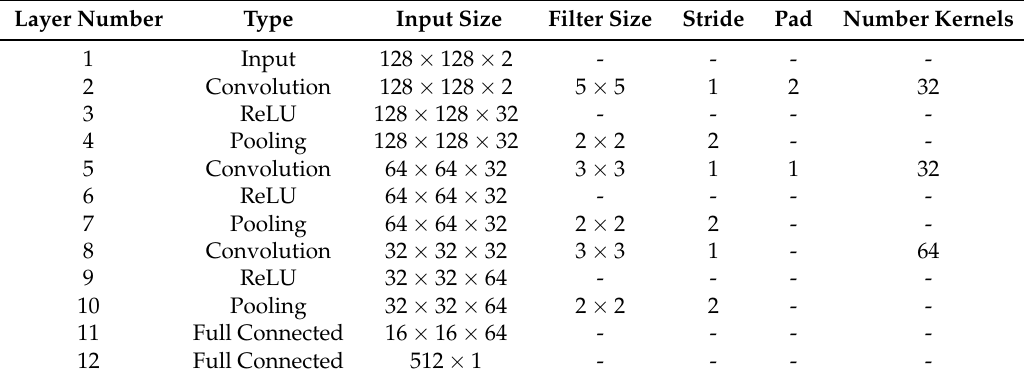
Figure 3. The architecture of the phase diversity-convolutional neural network (PD-CNN) network. Table 1. The configuration parameters of the PD-CNN